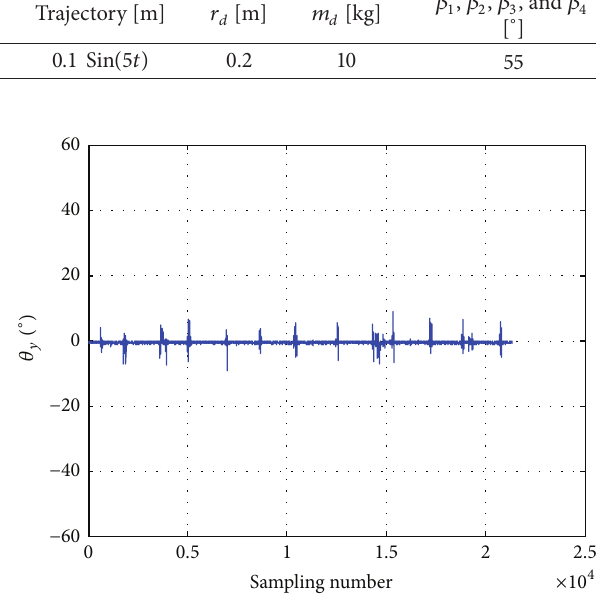
Figure 9: 𝜃 𝑦 for controlled system.